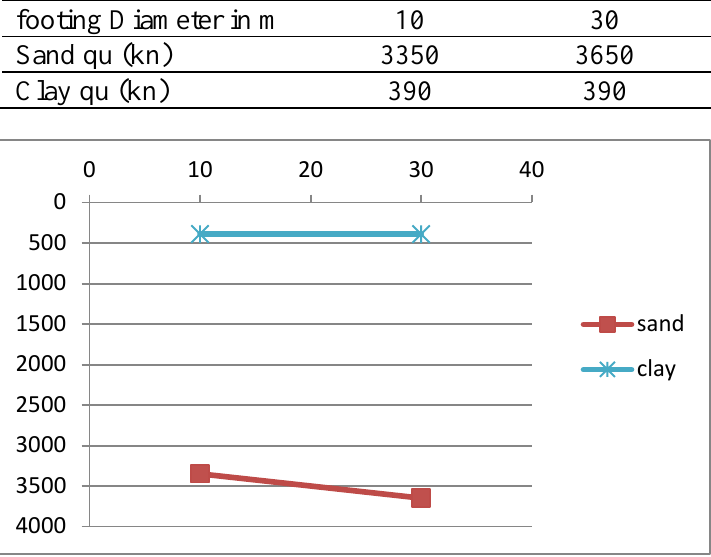
Table 2. Bearing capacity with different Sizes.